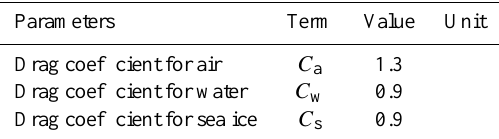
Table 6. Major parameters of the iceberg model. Parameters Term Value Unit Drag coefficient for air C a 1.3 Drag coefficient for water C w 0.9 Drag coefficient for sea ice C s